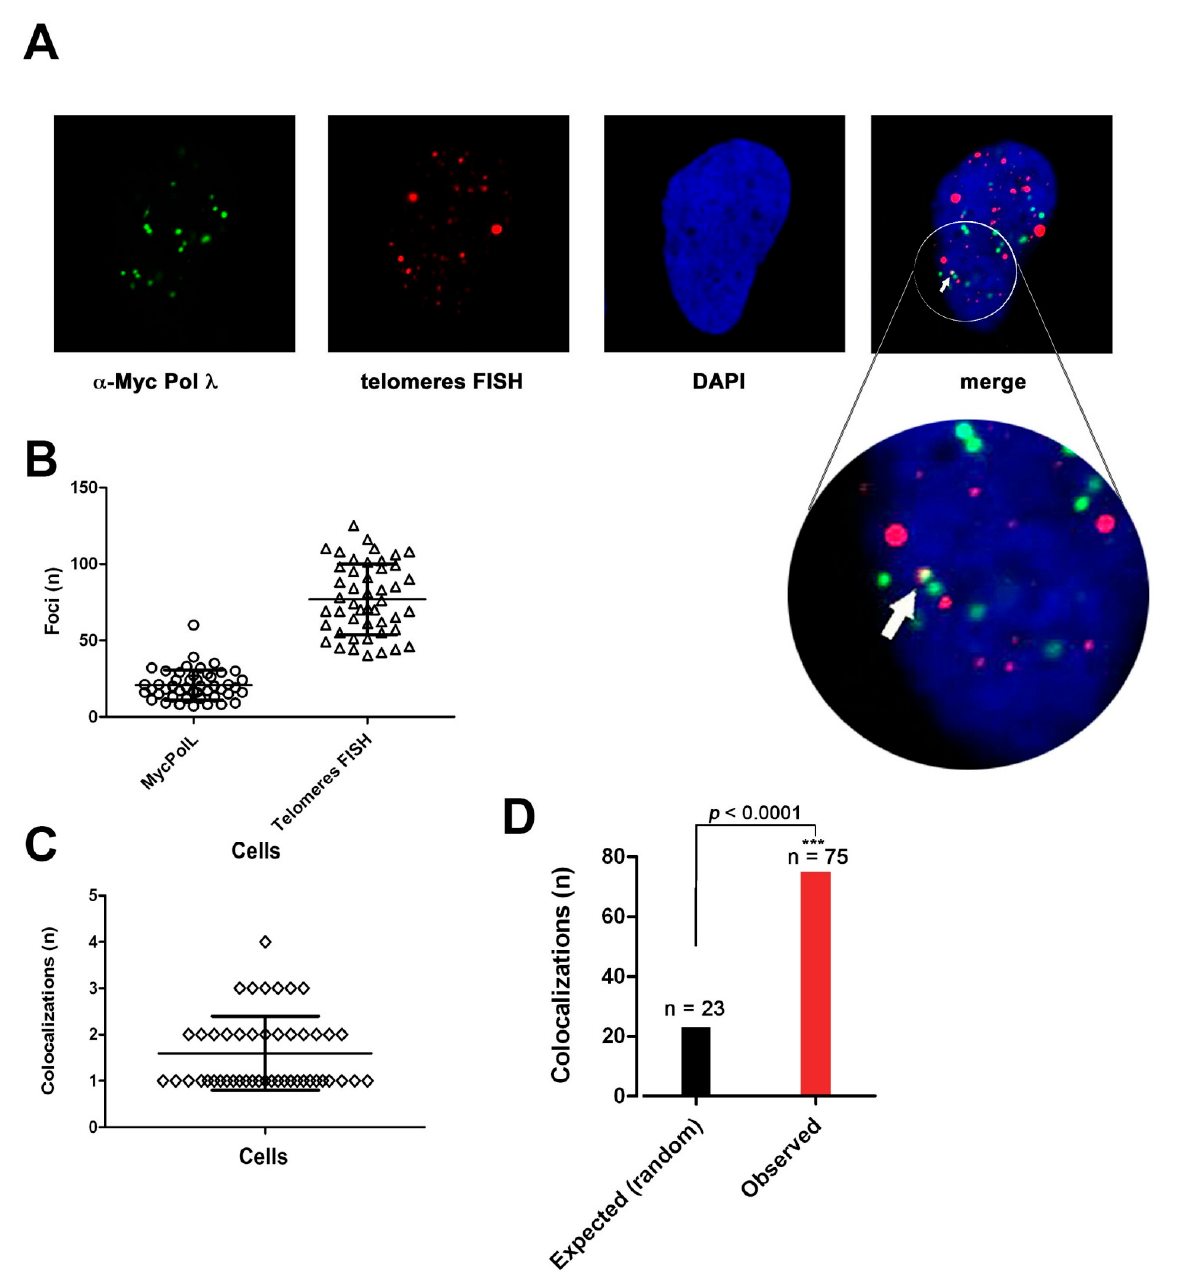
Figure 6. DNA polymerase λ associates with telomeres in ALT cells. ( A ) Confocal microscopy imaging of Pol λ colocalization with telomeres in Saos-2 λ 13 cell clone stably expressing c-Myc Pol λ . A representative colocalization event is indicated by the white arrow. ( B ) The number of signals (foci) detected, respectively, for Pol λ (circles) and telomeres (triangles) within a single cell is shown. ( C ) Number of observed colocalization events per cell. ( D ) Statistical analysis comparing the expected number (n) of colocalization events under the hypothesis of random chance colocalization, with the number of observed colocalizations. χ 2 p value is shown on top of the bars. ***, χ 2 p value < 0.005. In order to confirm that Pol λ and TPP1 colocalize in ALT cells, colocalization be ‐ tween Pol λ (visualized by α‐ cMyc Abs) and TPP1 (visualized by α‐ TPP1 Abs) was per ‐ formed on Saos ‐ 2 cells expressing Myc ‐ Pol λ , synchronized with HU and released for 6 h (Figure 7A). A total of 1243 TPP1 foci (range 5–203/cell) and 349 Pol λ foci (range 11–